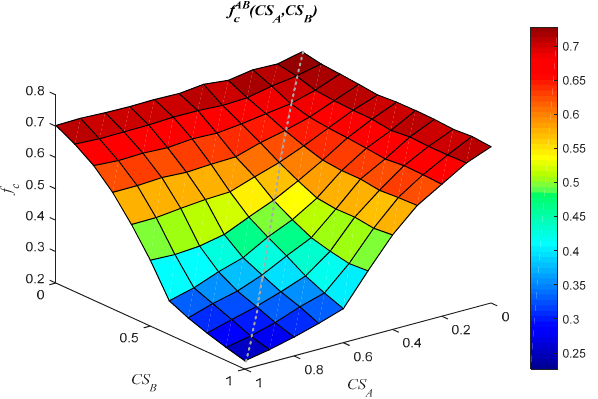
Figure 5. The three-dimensional curved surface of collapse threshold f c over various coupling strength (CS) under unilateral failure, each point is an average of 20 different network realizations. Sub-graph ( a – e ) show the cascading failure under specific coupling strength in one simulation.